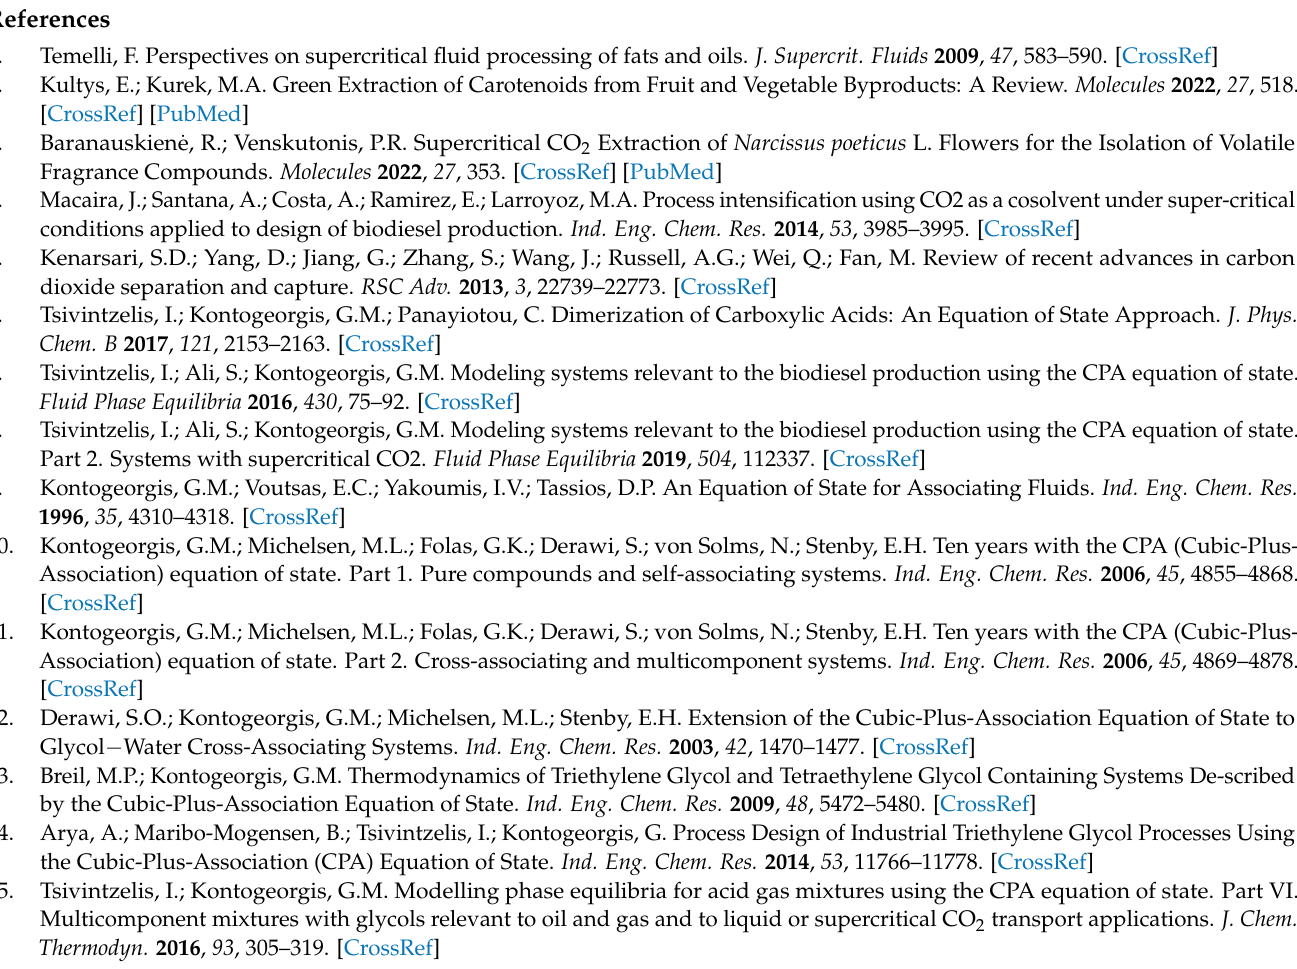
using the binary parameter of Table 5 of the main article; Figure S16: CO 2 –trimyristin VLE at 328 K. Experimental data [48] and CPA correlations using the binary parameter of Table 5 of the main article; Figure S17: CO 2 –triolein VLE at 313 K (vapor phase compositions). Experimental data [53,54] and CPA correlations using the binary parameter of Table 5 of the main article; Figure S18: CO 2 – triolein VLE at 323 K (vapor phase compositions). Experimental data [50,53,54] and CPA correlations using the binary parameter of Table 5 of the main article; Figure S19: CO 2 –triolein VLE at 333 K. Experimental data [51–53] and CPA correlations using the binary parameter of Table 5 of the main article; Figure S20. CO 2 –triolein VLE at 343 K. Experimental data [52,53] and CPA correlations using the binary parameter of Table 5 of the main